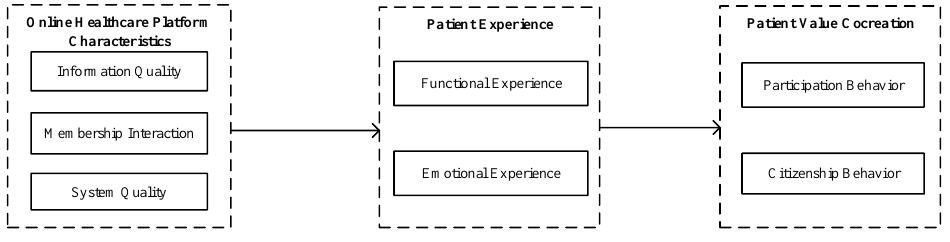
Figure 1. Theoretical Framework.